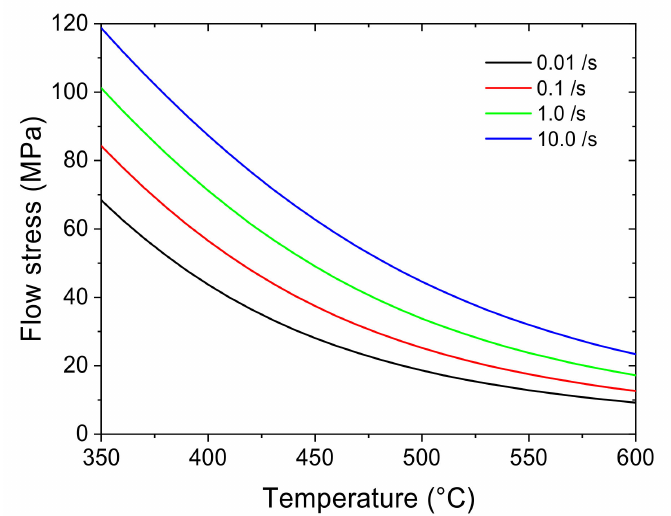
Figure 8. Predicted flow stresses by the Sellars–Tegart equation.